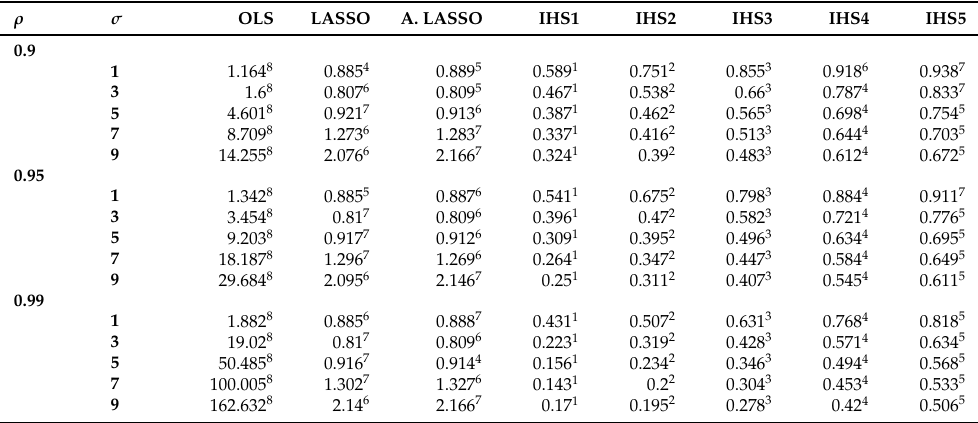
Table 3. Estimated MSEs for n = 150 and p = 4 (superscript represents